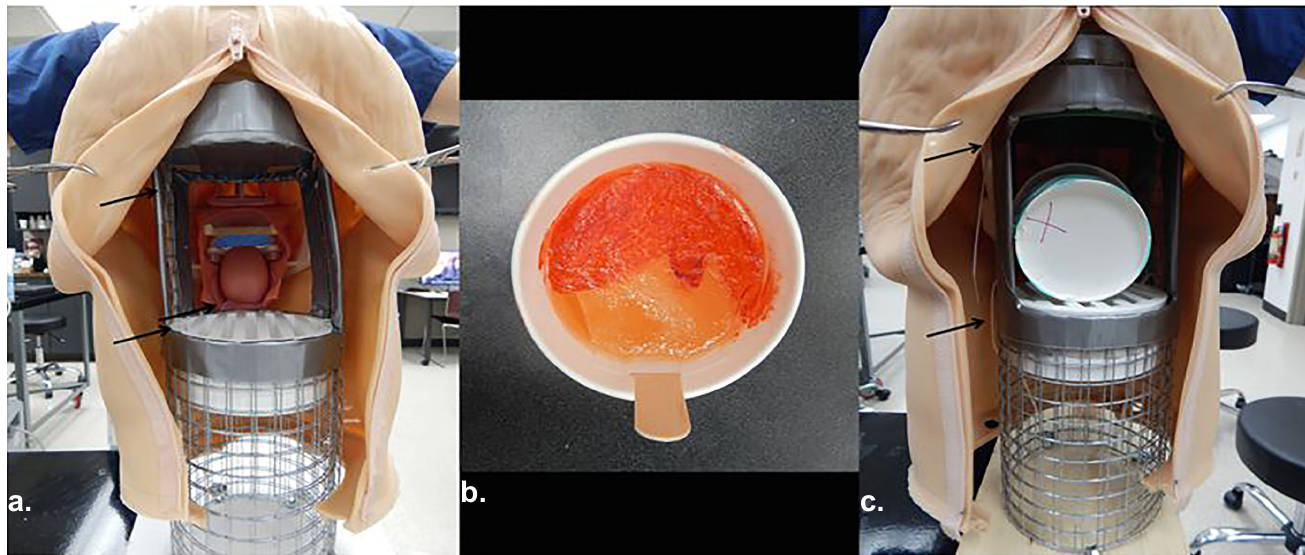
Figure 1. (a) Supportive mesh cylinder from behind; (b) Finished peritonsillar abscess cup; (c) Peritonsillar abscess cup inserted into task